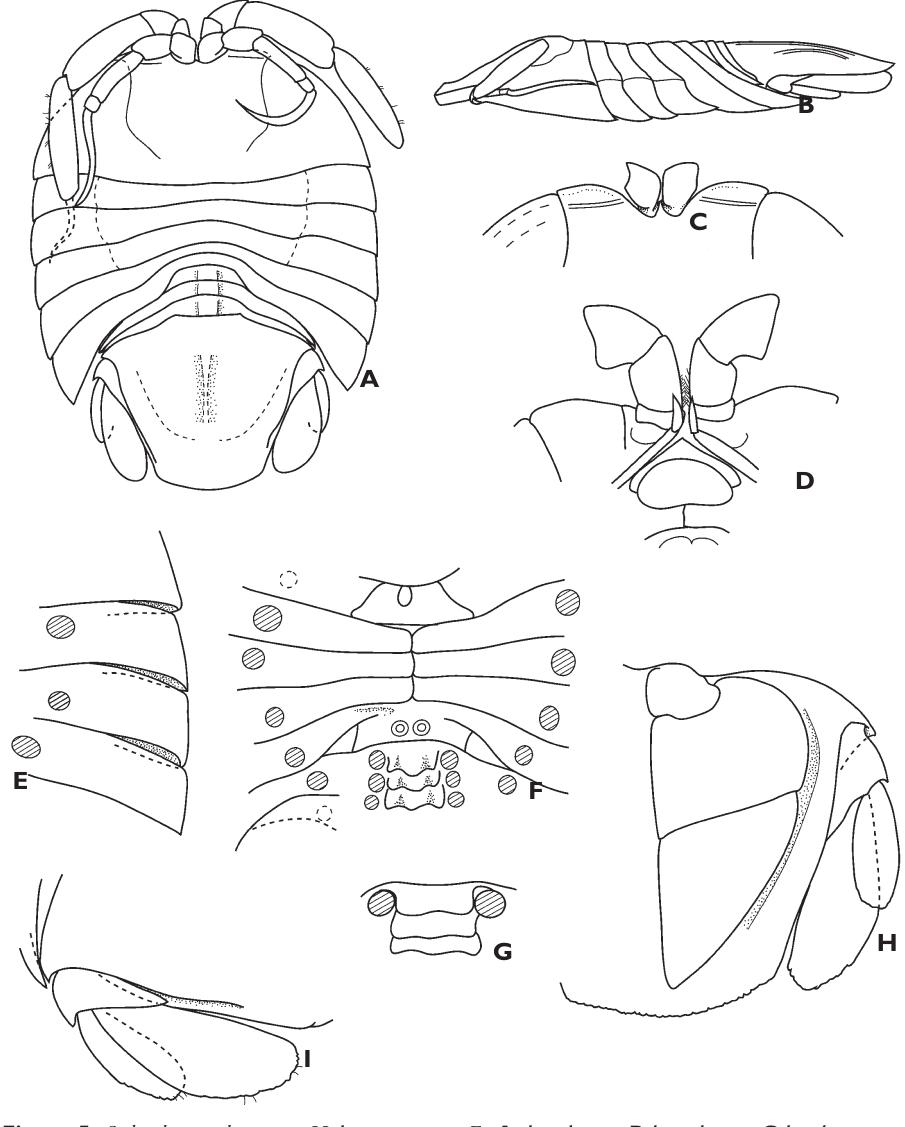
Figure 5. Sedorolis simplex sp. n. Holotype, except E. A dorsal view B lateral view C head, anterior margin D frons E ventral coxae 2–5 F male sternites and ventral pleonites G ventral pleonites, ♀ 5.3 mm, Is.6001 H pleotelson and uropods, ventral view I uropods, dorsal view in situ.